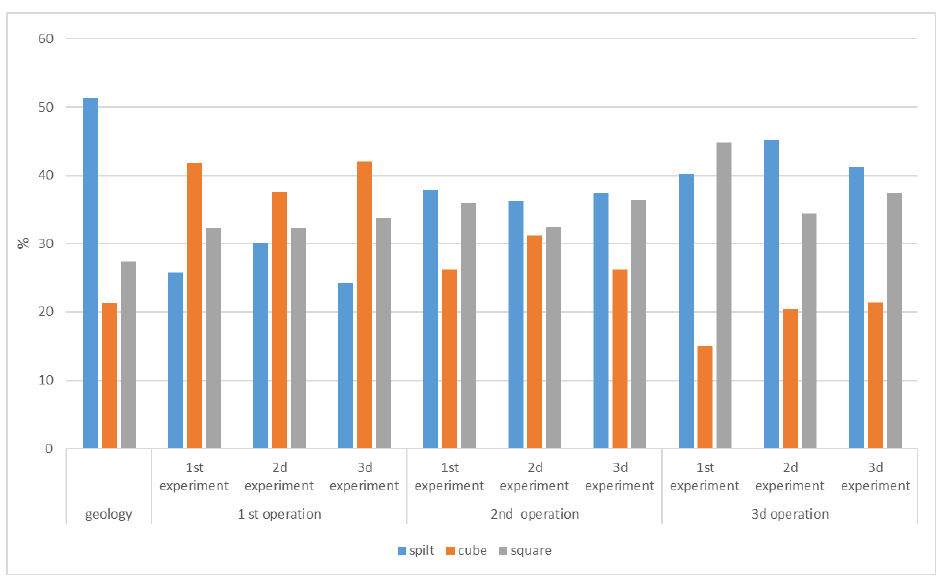
Figure 6. The experiment results: overall fragment form distribution for all experiments.